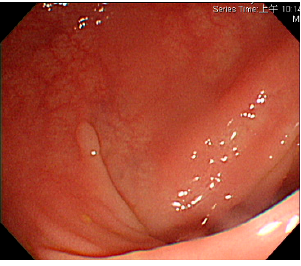
Figure 16. Unobvious polyp textures.